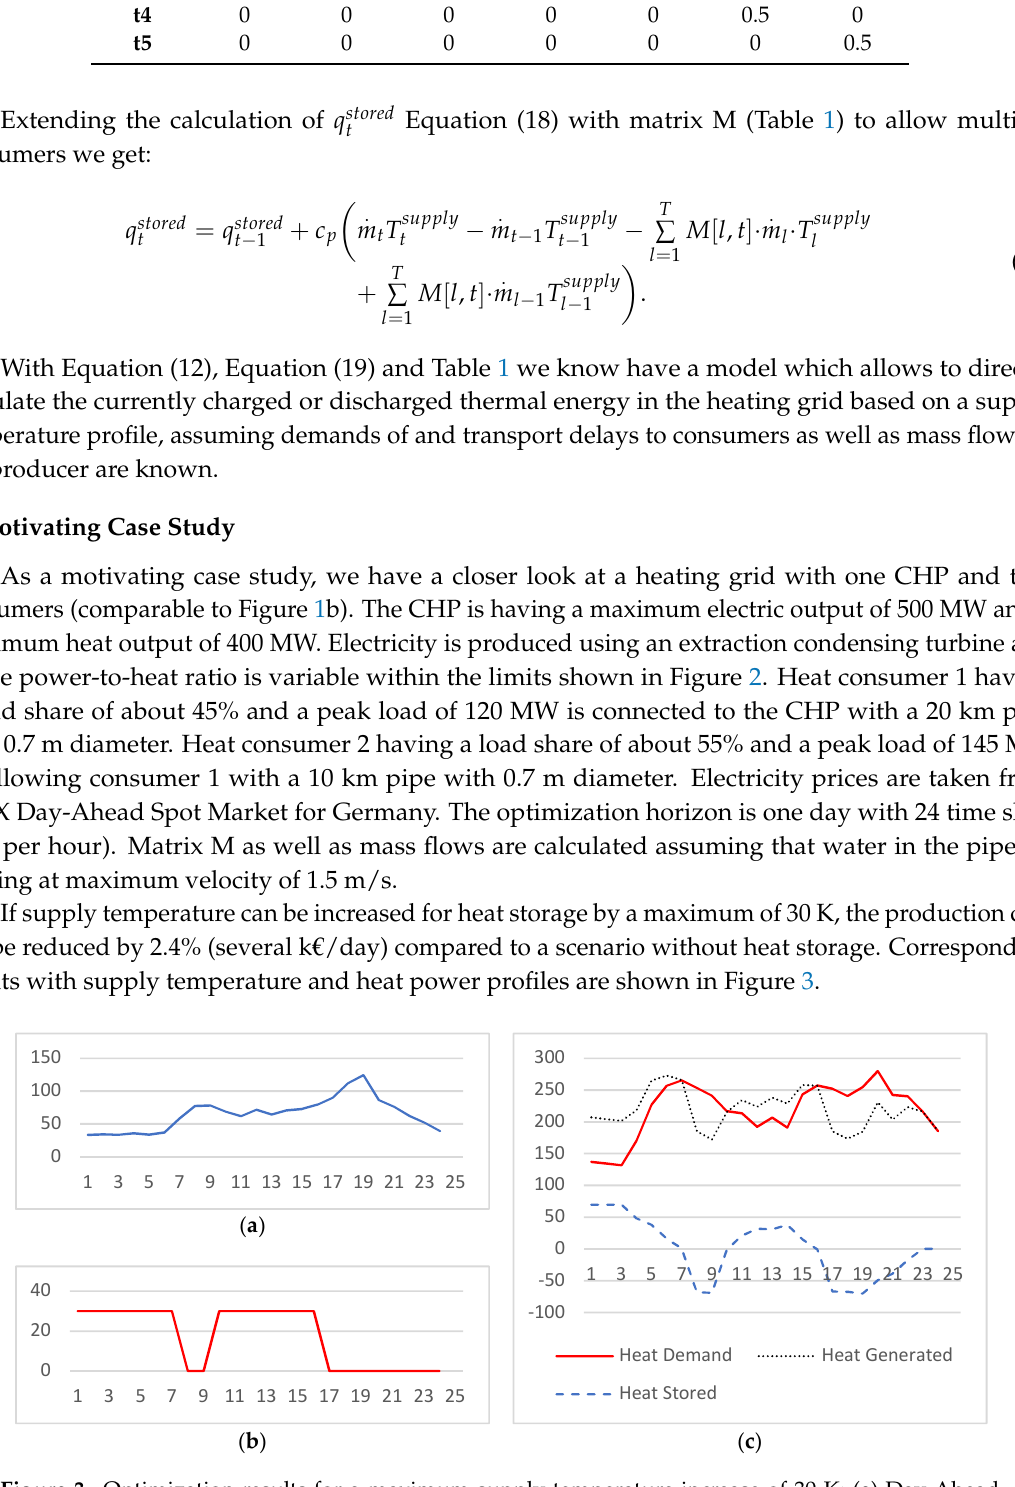
Figure 3. Optimization results for a maximum supply temperature increase of 30 K: ( a ) Day Ahead Electricity Price in €/MWh; ( b ) Supply Temperature increase at CHP in K; ( c ) Heat power profiles in MW. Table 2. Savings for different maximum increases of supply temperature.